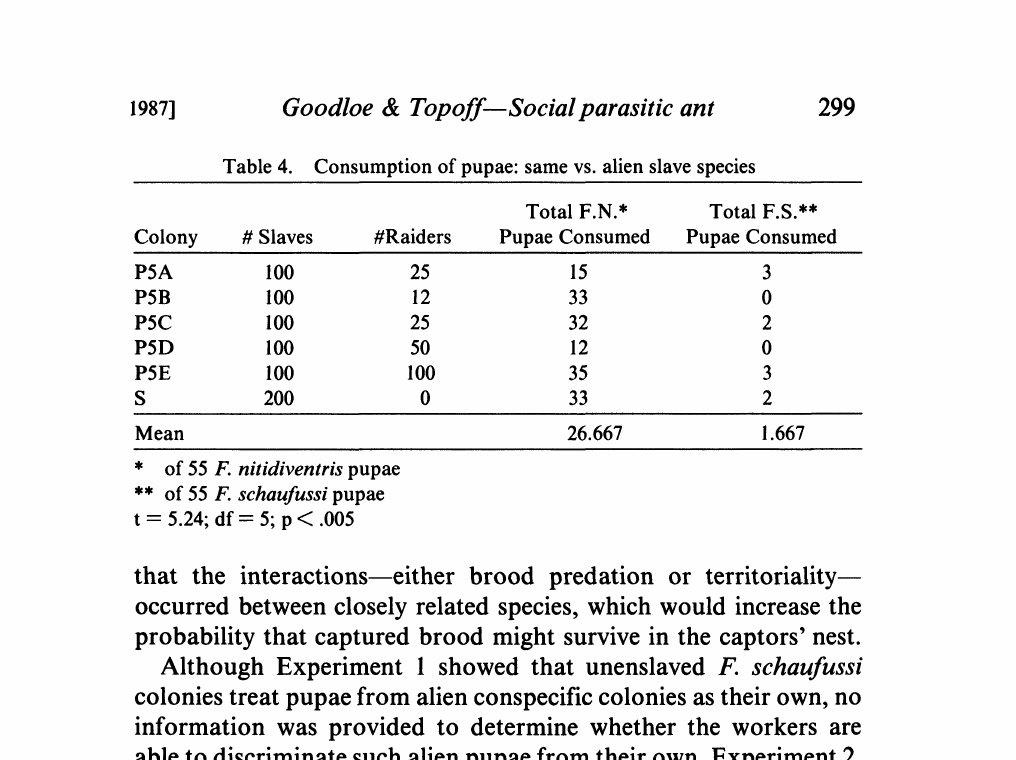
Table 4. Consumption of pupae: same vs. alien slave species